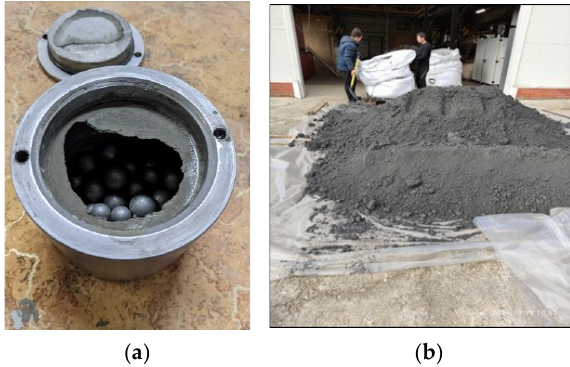
Figure 7. Ferromagnetic grinding media ( a ) and resulting powder ( b ).